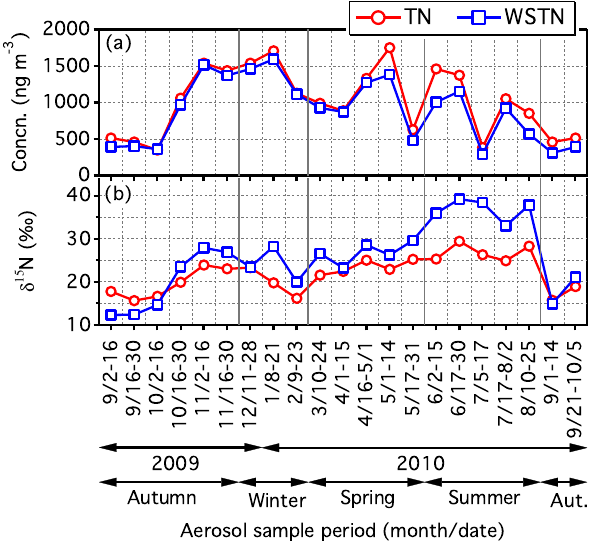
Figure 2. Seasonal variations in (a) concentrations of TN and WSTN and (b) N isotope ratios of TN ( δ 15 N TN ) and WSTN ( δ 15 N WSTN